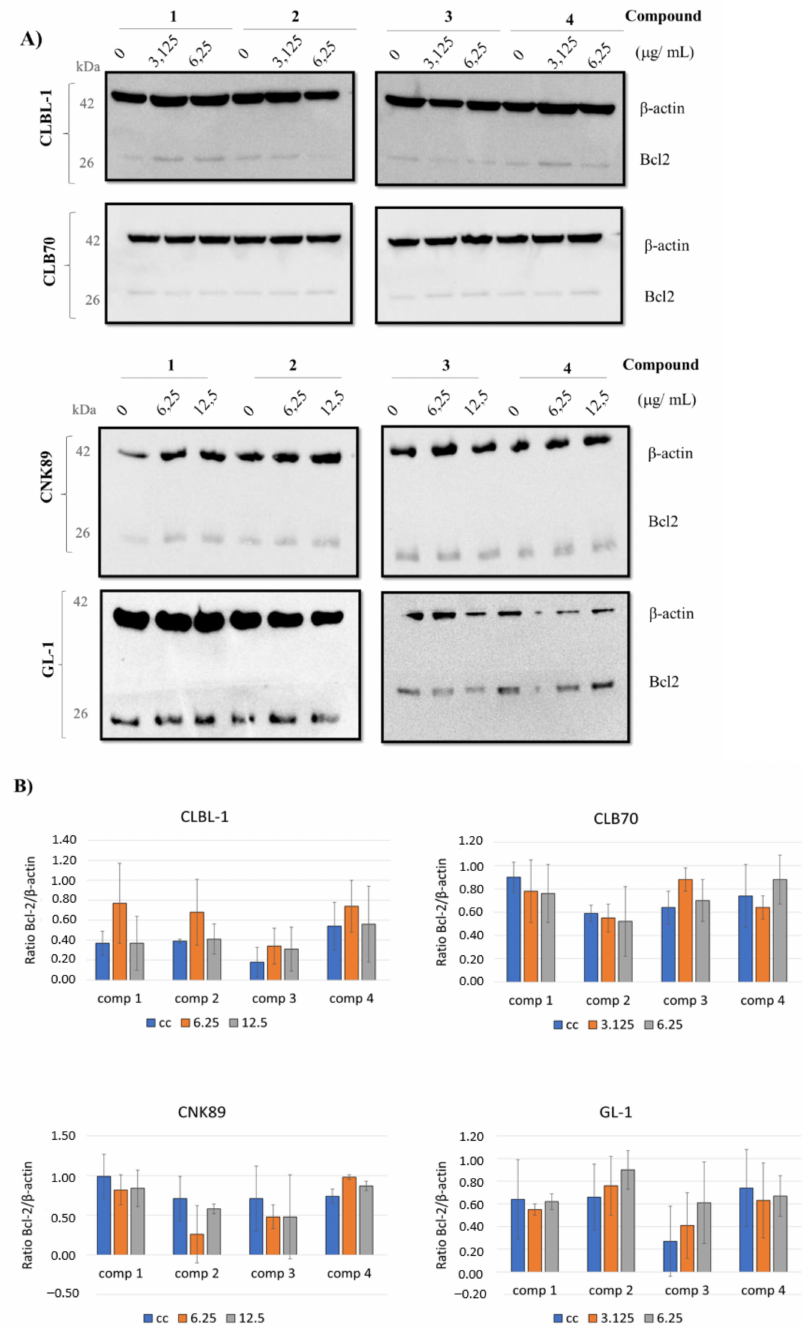
Figure 4. ( A ) Western blot analysis for Bcl-2 protein after 48 h of incubation with different concen- trations of flavanone-derived γ -oxa- ε -lactones: 3.125 and 6.25 µ g/mL for the sensitive cell lines (CLBL-1 and CLB70) and 6.25 and 12.5 µ g/mL for the resistant ones (CNK-89 and GL-1). ( B ) Protein quantification. The results are presented as mean ± standard deviation (SD) of three separate experi- ments. Statistical differences were analyzed using one-way ANOVA followed by Tukey’s multiple comparison test. No significant differences were found between the different concentrations for the same